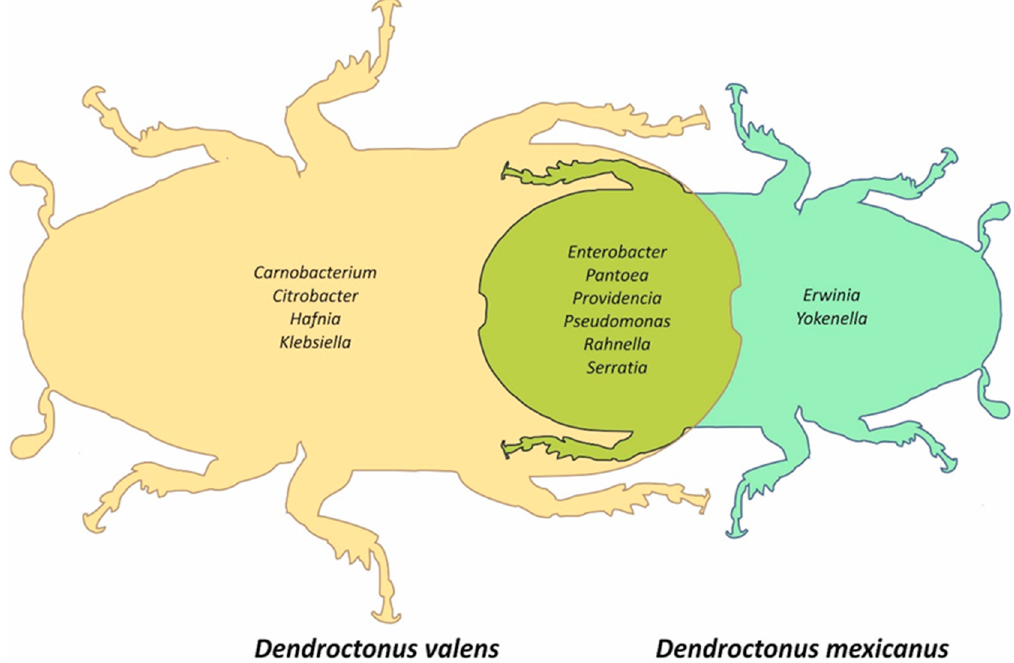
Figure 4. Venn diagram representing unique and shared taxa present in all localities between Dendroctonus valens and D. mexicanus .